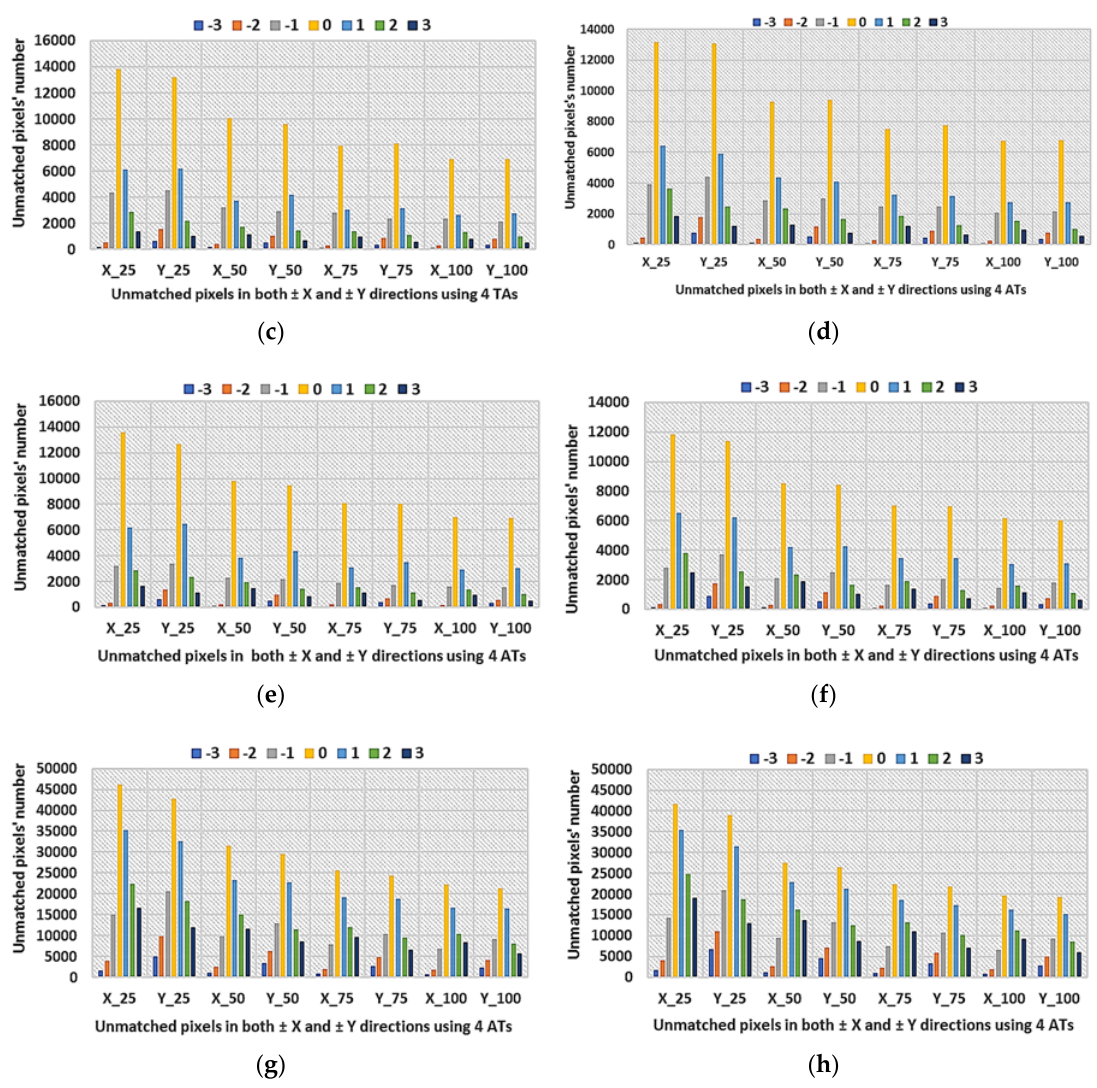
Figure 7. Deviations of channels’ pixels in in both ± X and ± Y directions at different ATs and PBTVs in a comparison between the networks extracted from both: ( a ) LiDAR DTM and SRTM 28.5 m, ( b ) LiDAR DSM and SRTM 28.5 m, ( c ) LiDAR DTM and ALOS DSM 28.5 m, ( d ) LiDAR DSM and ALOS DSM 28.5 m, ( e ) LiDAR DTM and PALSAR DEM 28.5 m, ( f ) LiDAR DSM and PALSAR DEM 28.5 m, ( g ) LiDAR DTM and PALSAR DEM 12.5 m, and h. LiDAR DSM and PALSAR DEM 12.5 m.